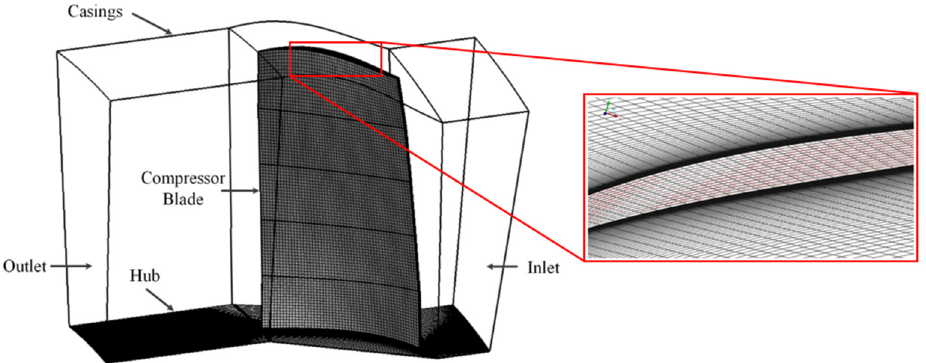
Figure 6. CFD model of compressor blade.